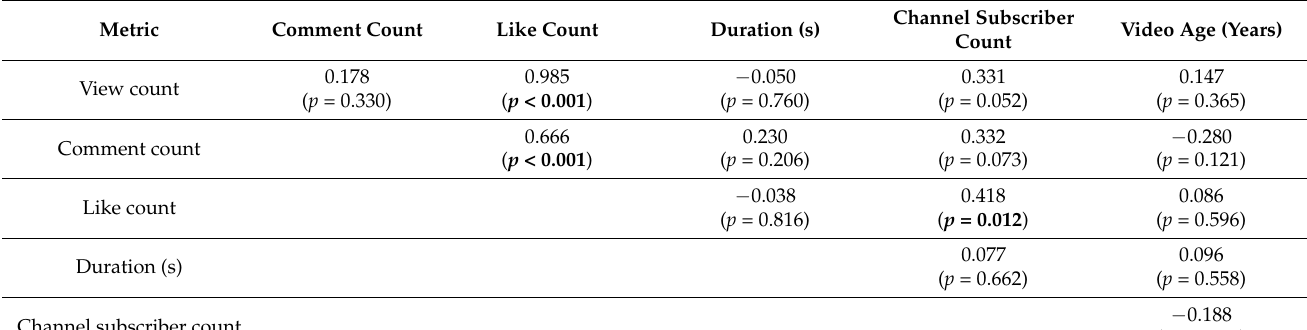
Table 5. Pearson correlation between the viewing